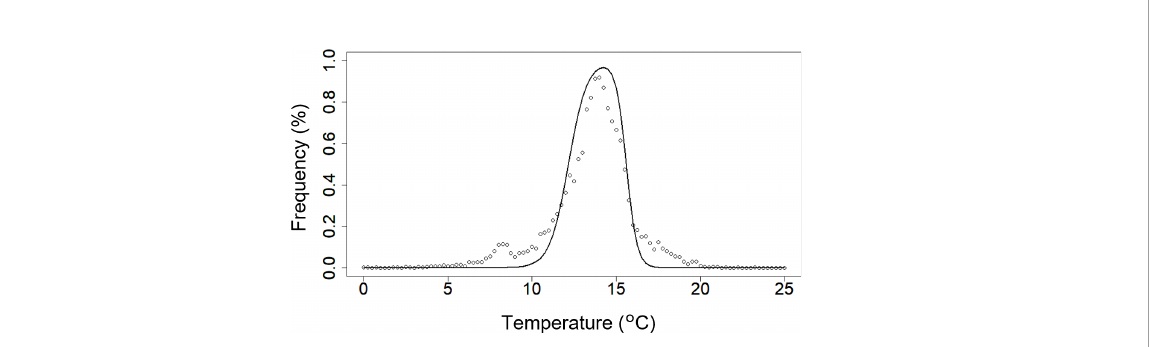
FIGURE 3 Frequency distributions of chlorophyll- a concentrations that exceeded 10 mg m − 3 (open circles) versus sea-surface temperature. The black line shows the f c ( T ) function fi tted to the data. The daily satellite-derived chlorophyll- a concentrations (SCCs) and Himawari-8-derived sea surface temperatures at longitudes of 140 – 150°E and latitudes of 40 – 46°N from 31 August 2021 to 31 December 2021 were collected from the European Union ’ s Copernicus Marine Service and the Japan Aerospace Exploration Agency P-tree system, respectively. The frequency distribution for SCCs exceeding 10 mg m − 3 was calculated as a function of sea surface temperatures on the basis of Kuroda et al. (2021).